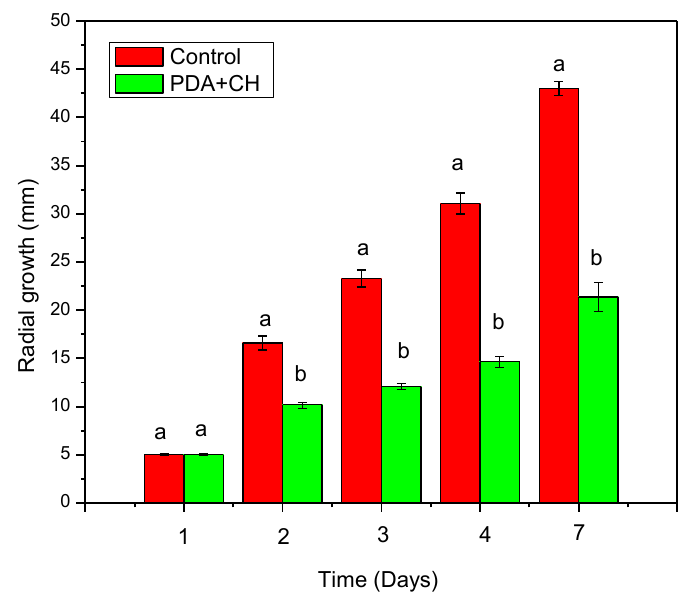
Figure 5. In vitro radial growth of Botrytis cinerea on PDA medium (control) or on PDA amended with chitosan hydrochloride (CH). For each evaluation date, columns with different letters are significantly different according to Tukey’s HSD test ( p = 0.01). Significant differences between two bars are marked with different letters; if there is no significant difference between two bars they get the same letter.